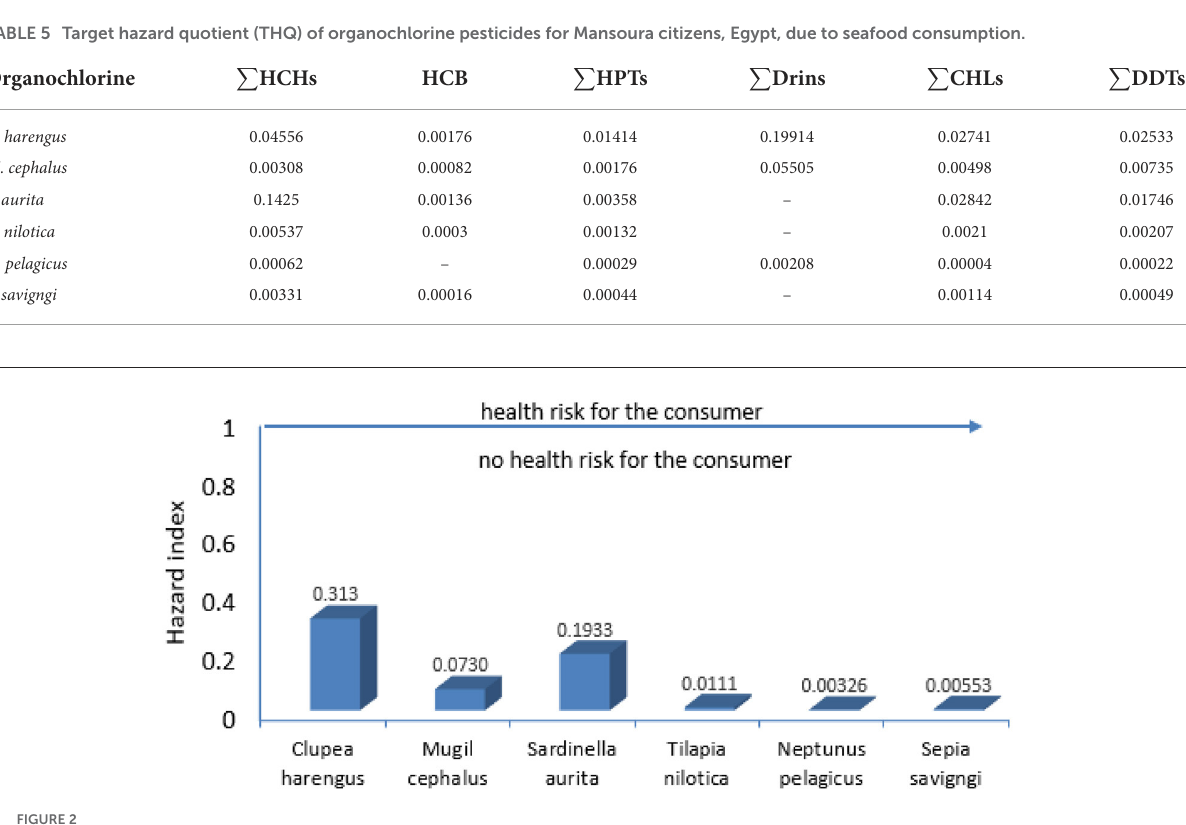
FIGURE2 Hazard index for Mansoura citizens, Egypt, due to consumption of different